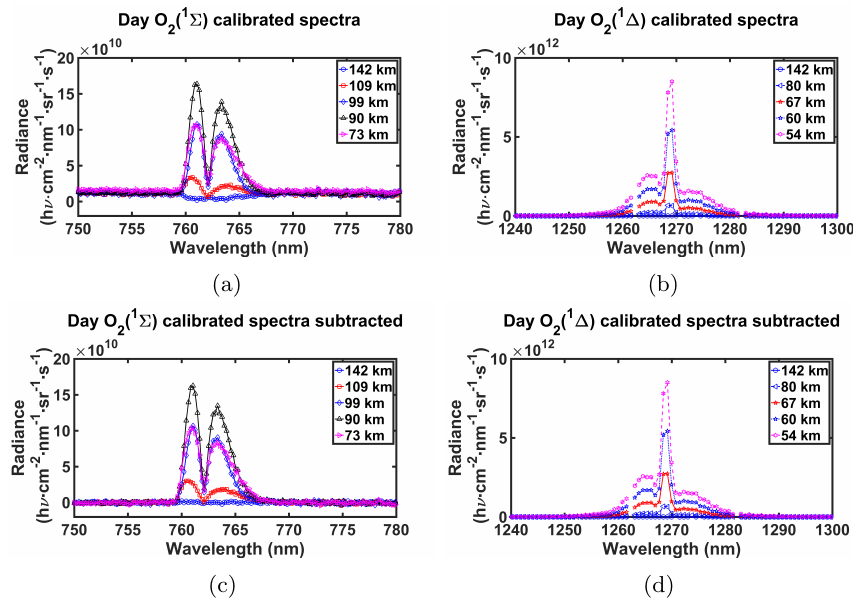
Figure 2. Examples of the daytime-calibrated spectra and the background-corrected spectra. (a) O 2 ( 1 (cid:54)) on 3 February 2010; orbit 41455; mean latitude 17.3 ◦ N, mean longitude 94.3 ◦ E. (b) as (a) but for the O 2 ( 1 (cid:49)) band. (c) as (a) but with background correction applied. (d) as (b) but with background correction applied.